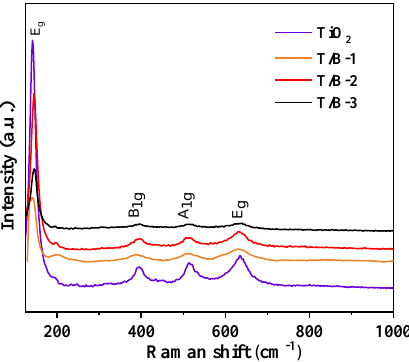
Figure 6. Raman spectra of TiO2, T/B-1, T/B-2, and T/B-3 fibers. The Raman active modes of anatase of TiO 2 are located around 145 cm − 1 (E g ), 394 cm − 1 (B 1g ), 518 cm − 1 (A 1g ), and 639 cm − 1 (E g ), respectively [37]. Raman spectra of pure TiO 2 samples can prove that it has the characteristics of the anatase phase. With the increase in the concentration of BiOI on TiO 2 , the E g characteristic peak of TiO 2 in composite fiber gradually weakened, which means that the shading effect of the BiOI nanosheet cluster on TiO 2 fiber was enhanced. However, when the precursor ratio of TiO 2 to BiOI is 1:2, the peak value of T/B-2 rises again, because BiOI can be well compounded on TiO 2 fiber when the ratio of TiO 2 to BiOI was 1:2. The submicron sheet clusters would not interfere with each other, and TiO 2 should not be excessively shaded by BiOI, which can be observed by SEM images. With the increase in the concentration of BiOI, the E g characteristic peak of TiO 2 at 143 cm − 1 has a red shift to 141.3 cm − 1 , and the E g peak at 636.3 cm − 1 has a blue shift to